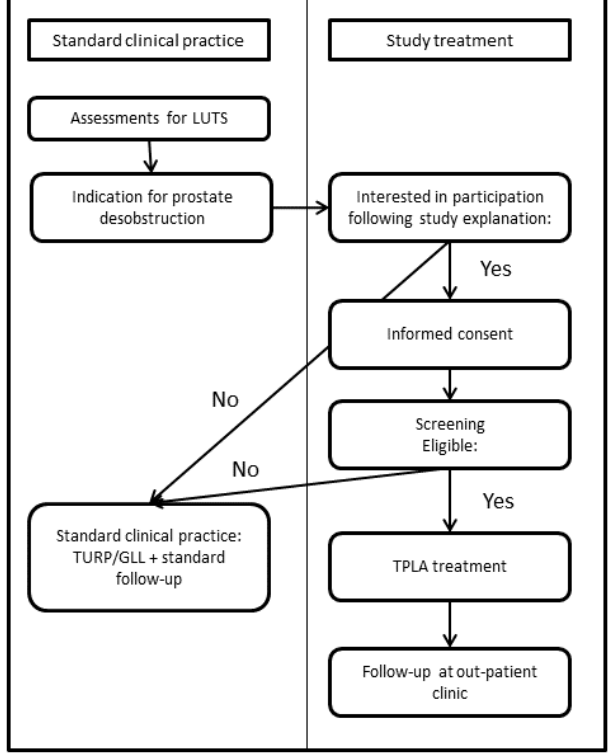
Figure 1. Flow diagram of the study design. LUTS: lower urinary tract symptoms; TPLA: transperineal laser